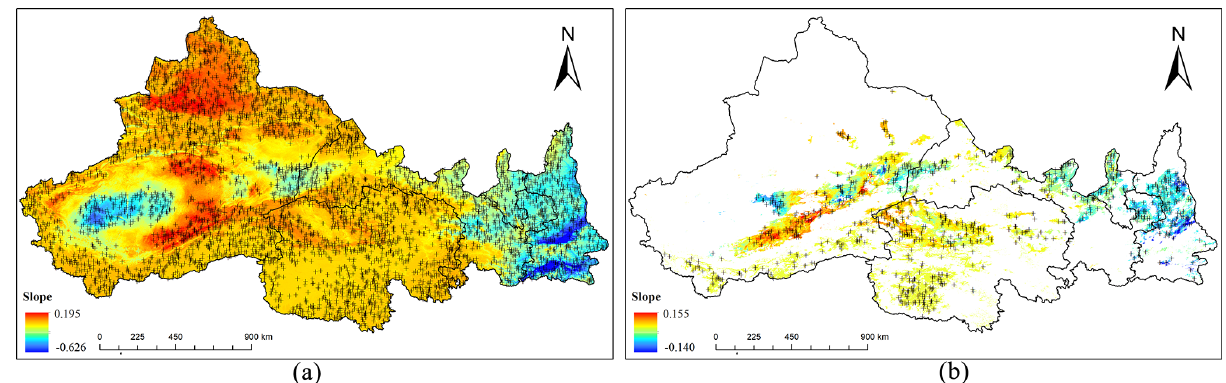
Figure 6. Spatial patterns of AOD trends obtained by removing seasonal cycles between 2000 and 2019: (a) FEC AODs (10 − 3 ) and